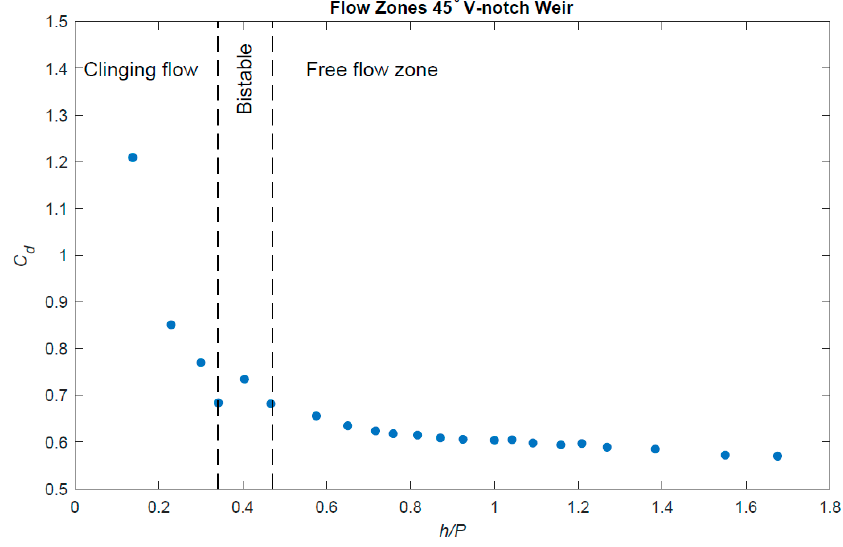
Figure 9. Discharge coefficient ( C d ) plotted against the ratio h/P for the data of the 45° weir observed.